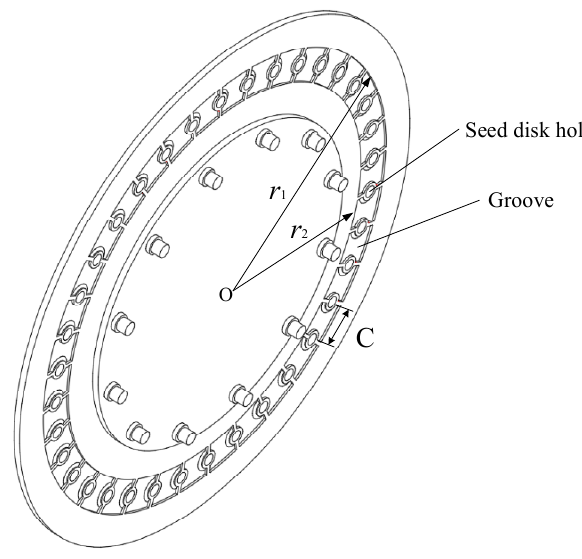
Figure 2. Two-dimensional sketch of the seed disk.